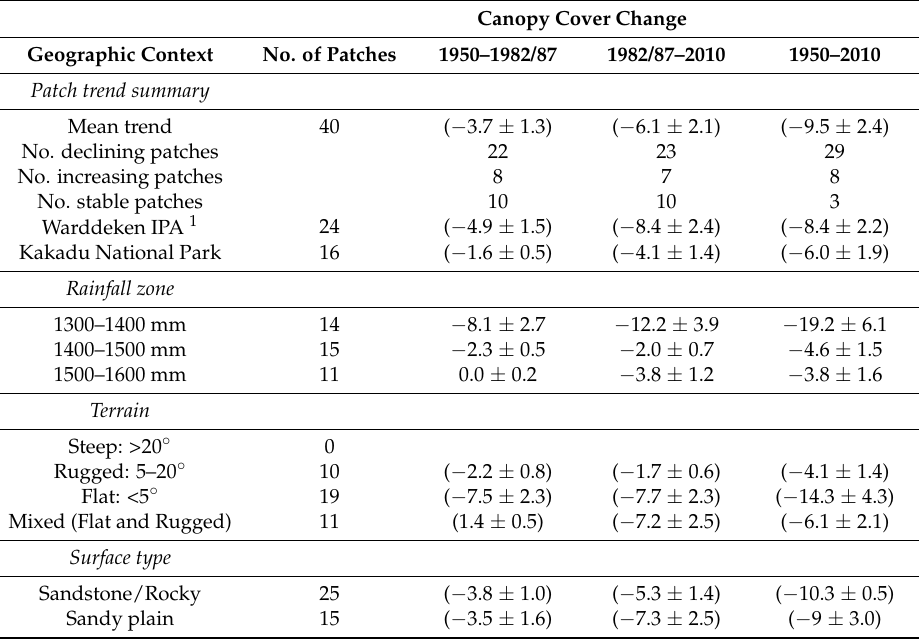
Table 3. Summary of canopy cover change, 1950–2010, at 40 study sites. Numbers in parentheses = % ± S.E.M.